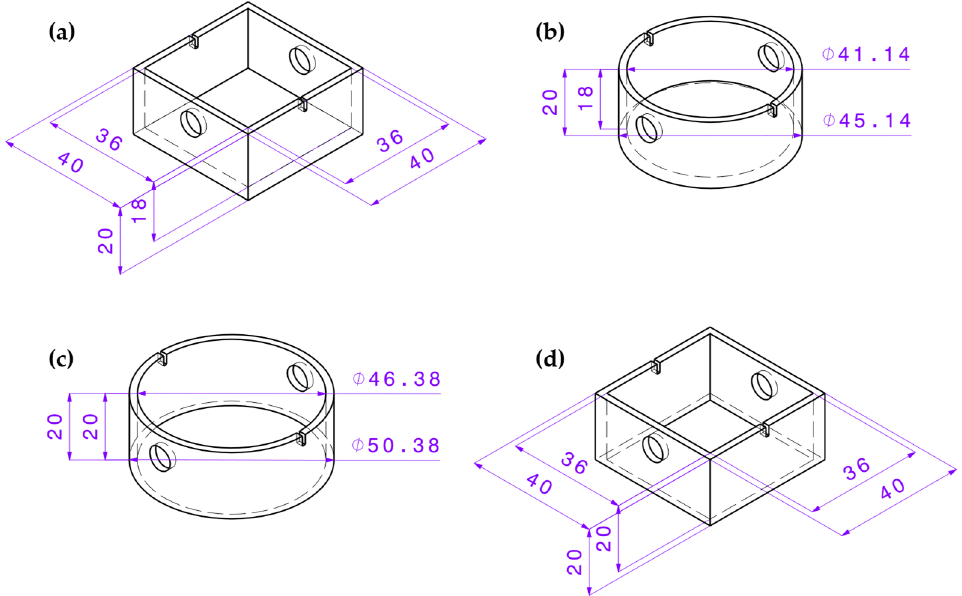
Figure 1. Specimen geometries ( a ) square with base (EG), ( b ) round with base (RG), ( c ) round without base (RO) and ( d ) square without base (EO) with specimen dimensions [7]. Unit: mm